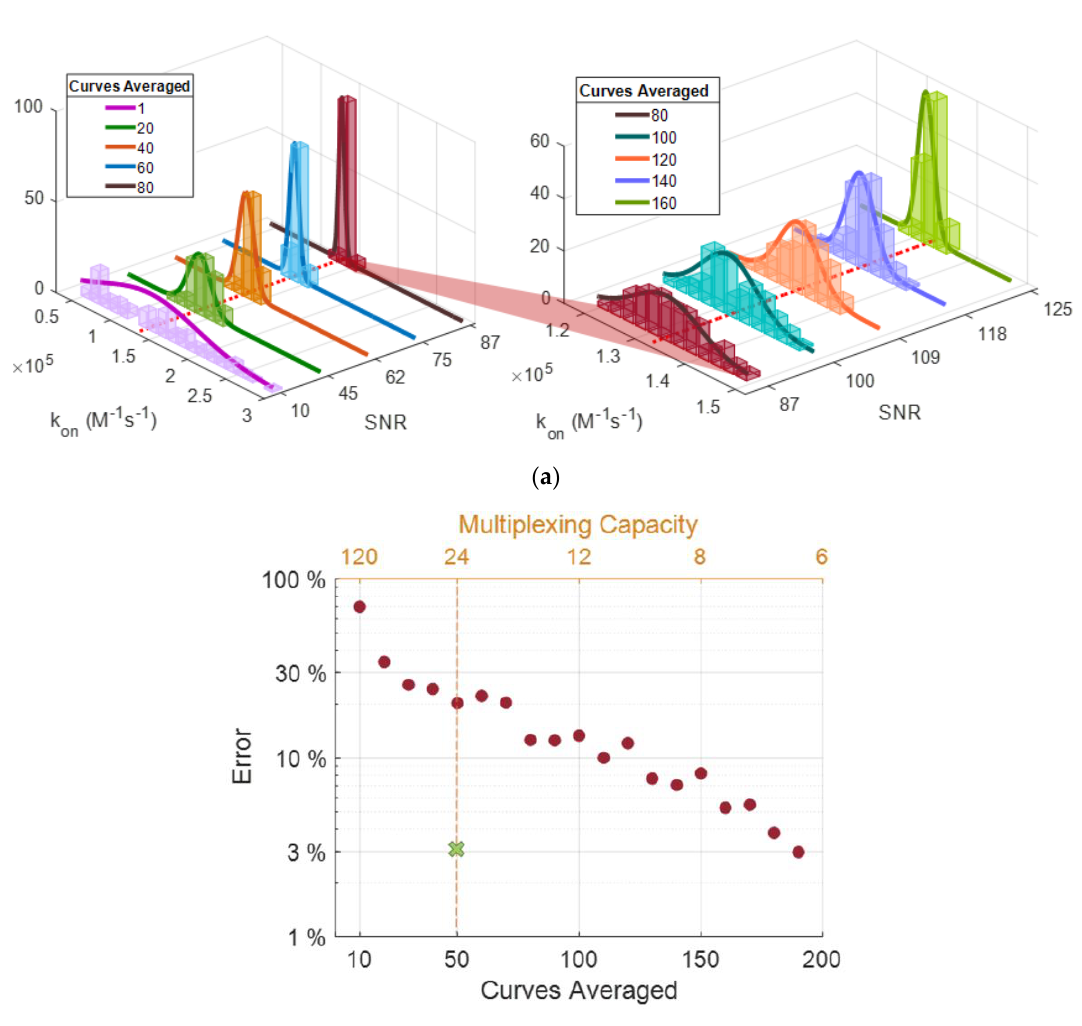
Figure 9. ( a ) Histograms for the extracted k on values with a corresponding number of curves averaged and the yielding SNR values (SNR ( a ) 10–87, ( b ) 87–125). The red-dotted line represents the actual calculated k on value (1.33 × 10 5 ). ( b ) The highest percent error was observed from each group of kon estimations from averaging steps. The marked spot on the plot (green) represents the projected percent error from micropipette spots on the 24-multiplexing line.